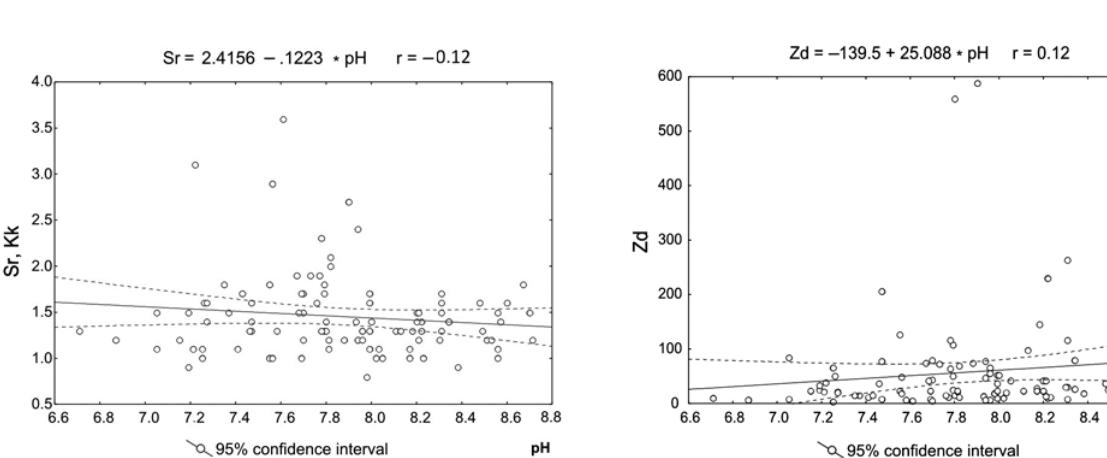
Fig. 4. Correlation ( r ) between concentration coefficient of copper (Cu) and topsoil pH in eldership of Šnipiškės of the city Vilnius